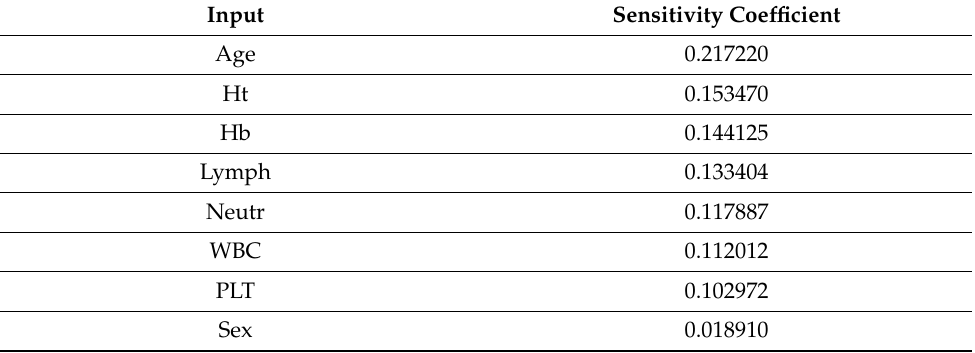
Table 7. Sensitivity